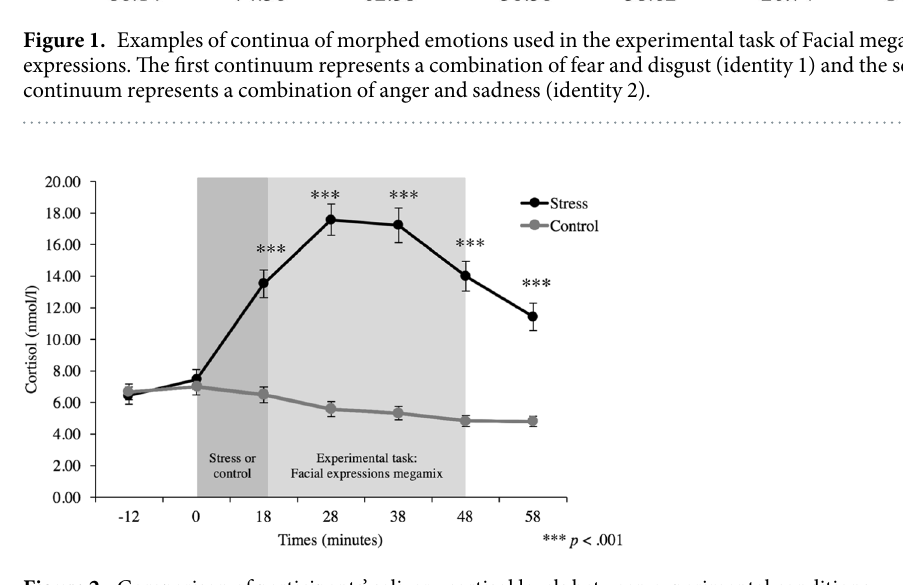
Figure 2. Comparison of participants’ salivary cortisol levels between experimental